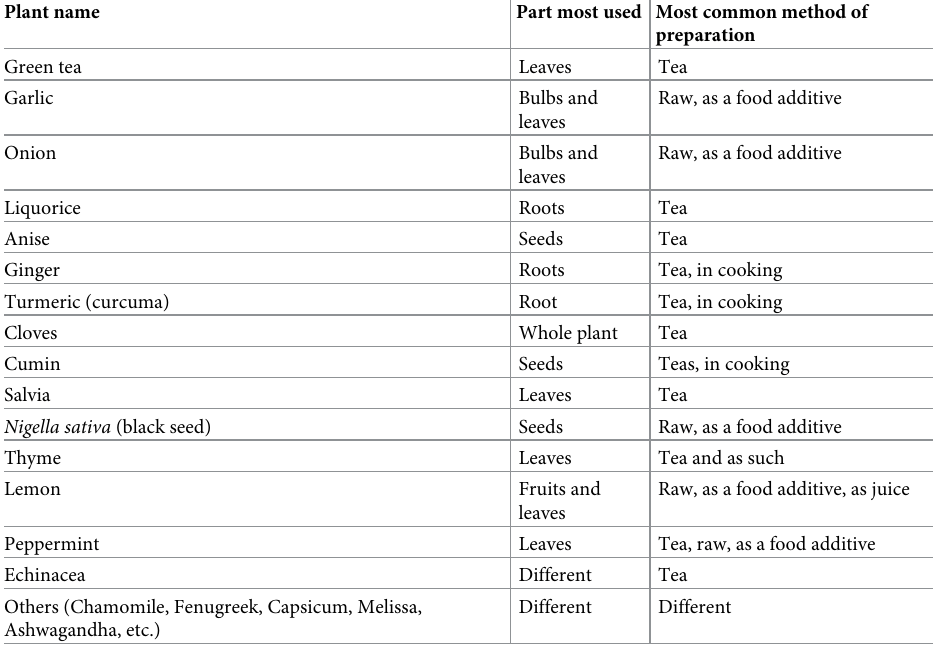
Table 3. Plants’ parts and preparations most used for COVID 19